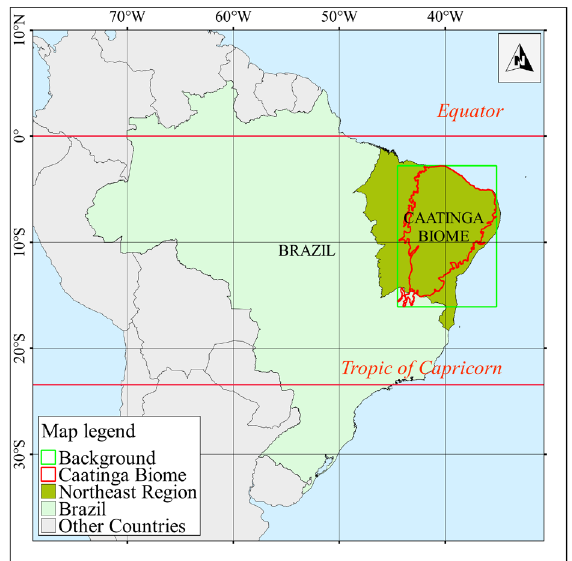
Figure 1. Location of the Caatinga biome.